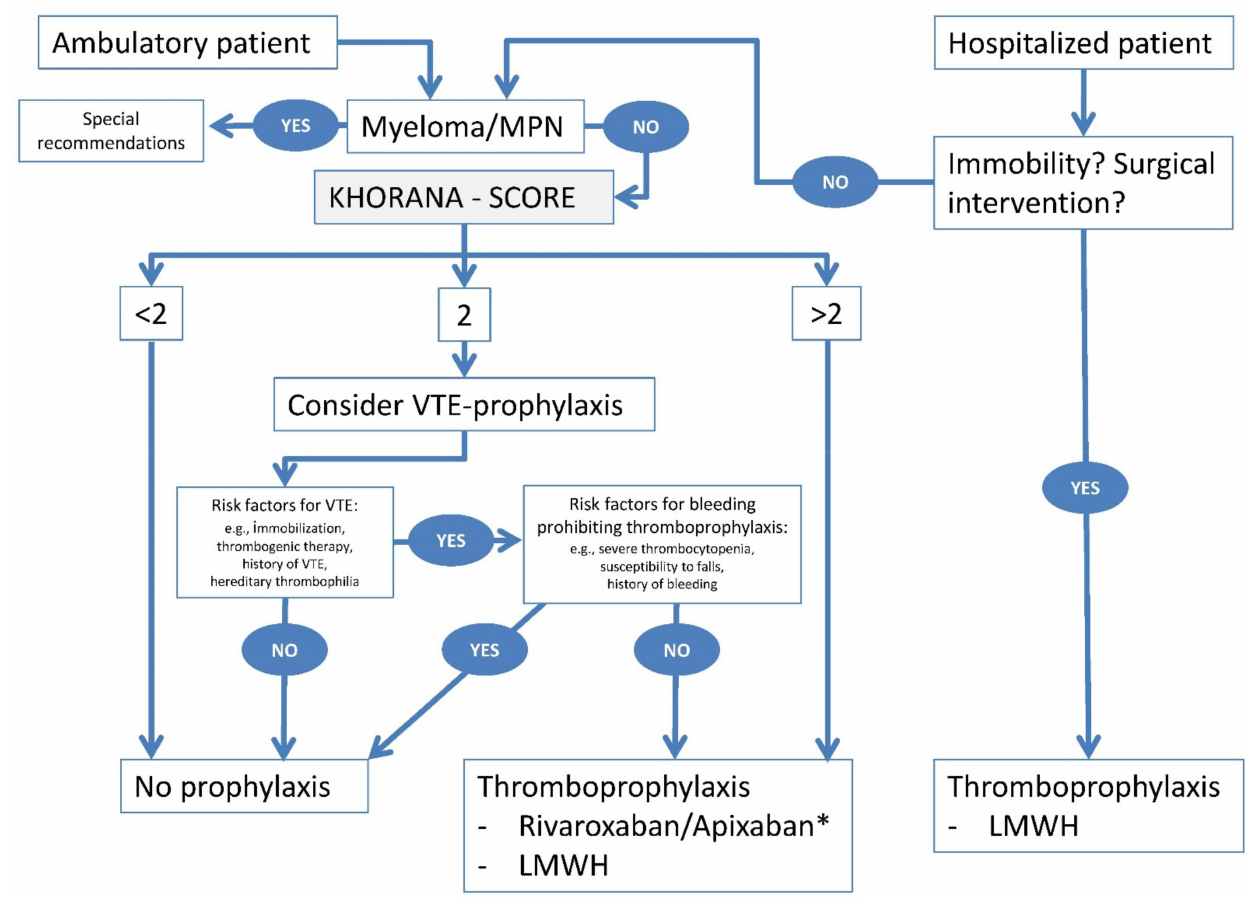
Figure 1. Algorithm for individual decisions for primary thromboprophylaxis in cancer patients. Of note, each